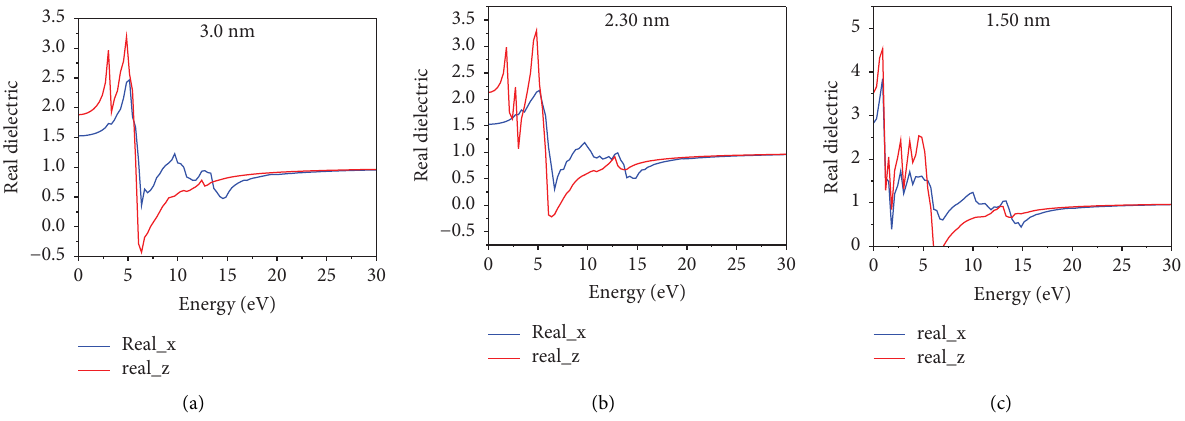
Figure 8: Real dielectric functions for armchair CBNNT under diferent IWDs.